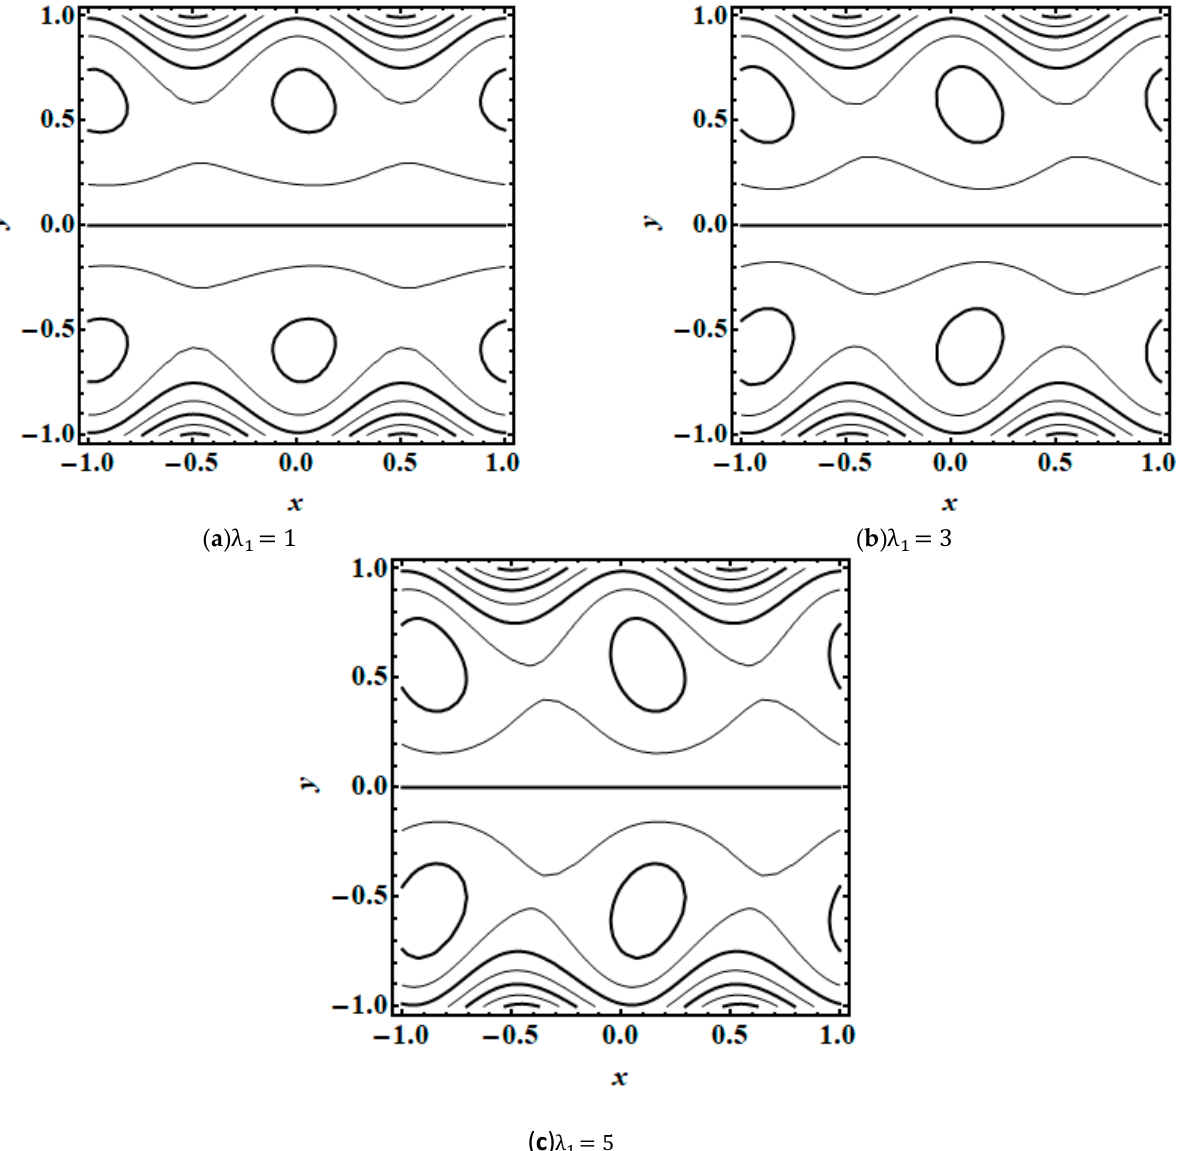
Figure 8. Influence of the fluid parameter λ 1 on the streamline patterns for α = 0.4, β = 0.4, ε = 0.1, Q = 1.5, M = 1, K = 0.1, Re = 0.1.